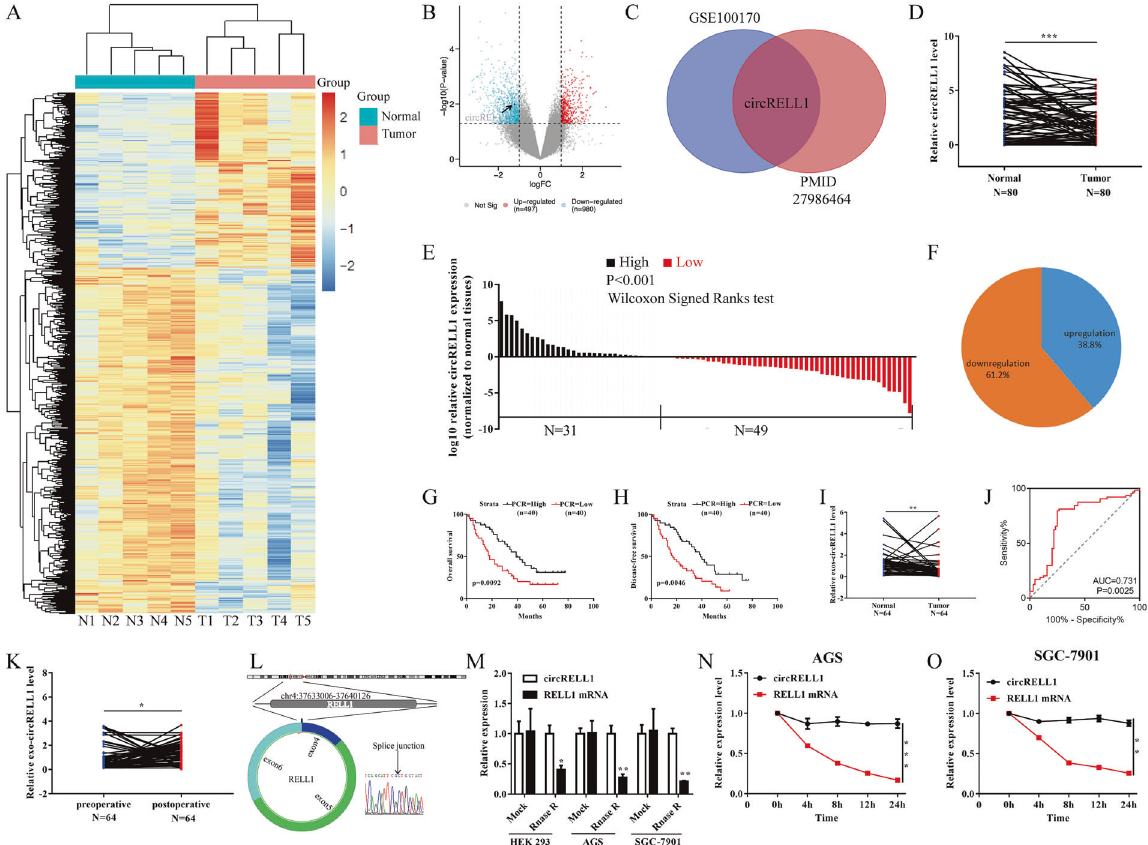
Fig. 1 CircRELL1 is downregulated in GC and associated with poor prognosis. A Heat map analysis of circRNA expression pro fi le in GC samples based on the GSE 100170. B Volcano plot showing circRNA transcript levels in GC and matched normal tissues. C The